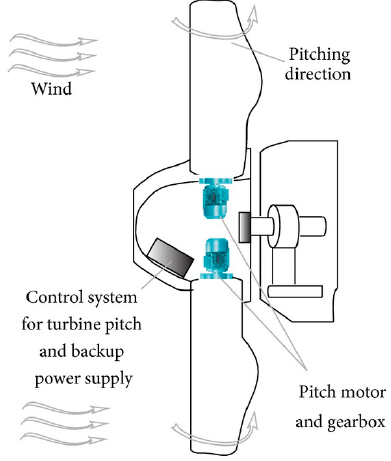
Figure 4. Pitch Control Wind Turbine.